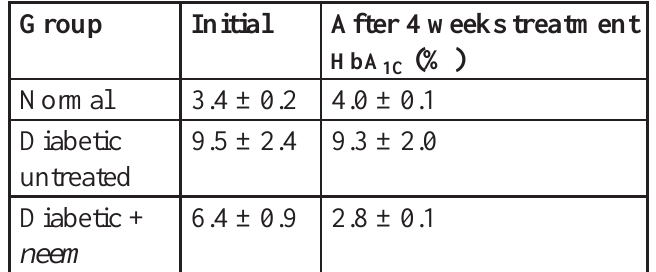
Table 4: Effect of treatment with water extract of leaves A. in- dica on glycoslated hemoglobin (HbA 1C ). The normal value for HbA 1C is 3.4 ± 0.2.